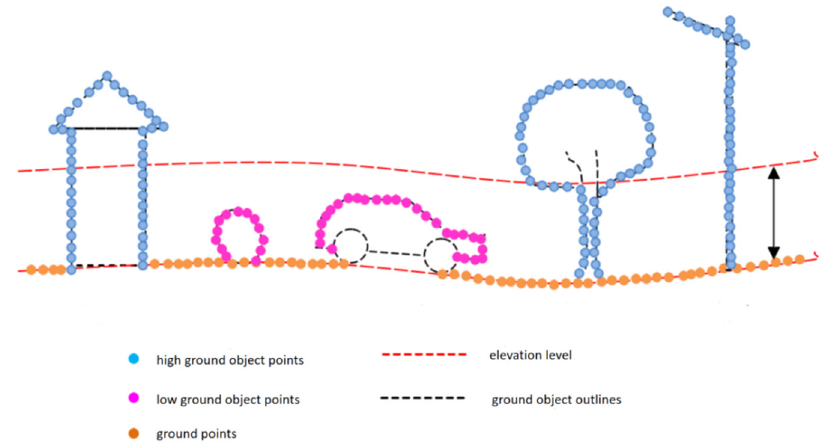
Figure 2. Ground object points based on height attribute.